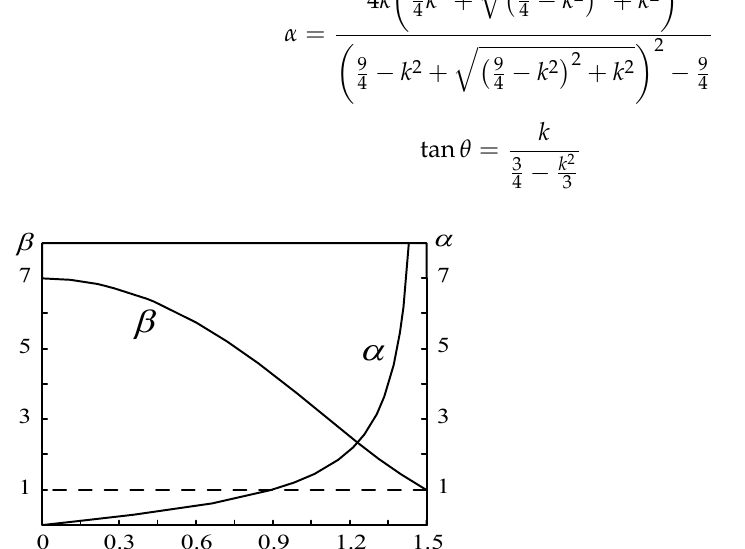
Figure A4. The curves of α and β with respect to k .